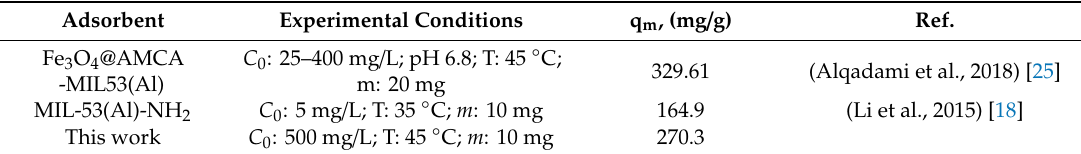
Table 3. Comparison of previous study for the removal of MG dyes from aqueous medium. Adsorbent